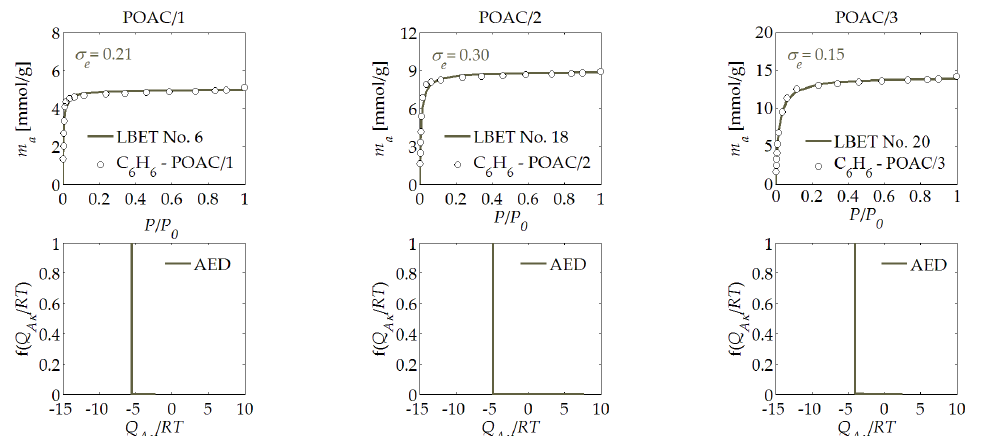
Figure 4. The same as Figure 1, but for the POAC/ R activated carbon derived from pistachio nut shells.